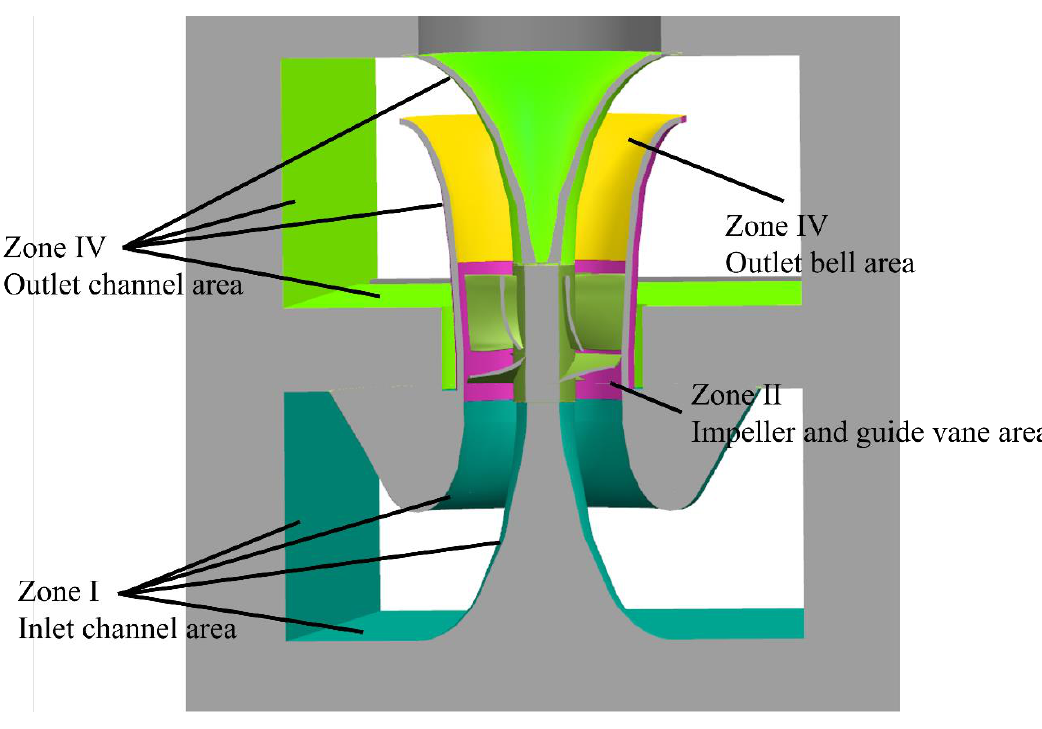
Figure 12. Schematic diagram of water pressure pulsation loading zoning.